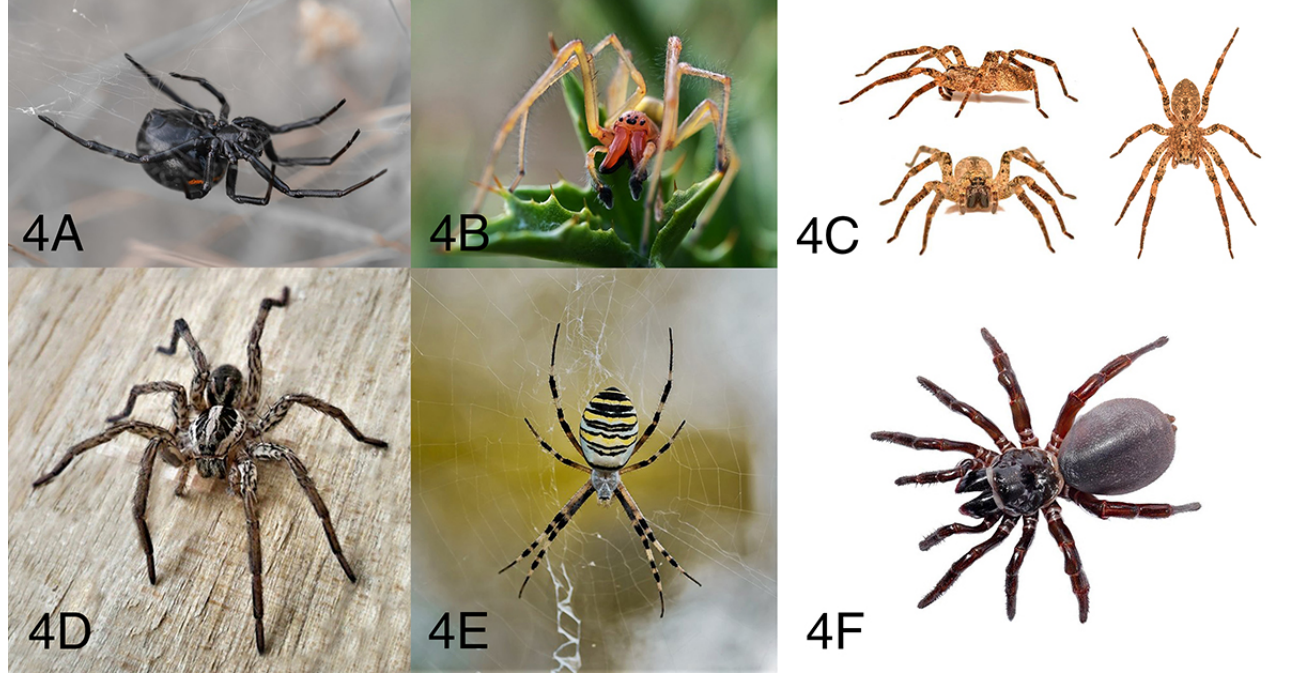
Figure 4. (A) Steatoda paykulliana (photo courtesy of Gianluigi Foggia). (B) Cheiracanthium punctorium (photo courtesy of Gianluigi Foggia). (C) Zoropsis spinimana (photo courtesy of Pierluigi Rizzo). (D) Hogna radiata (photo courtesy of Gianluigi Foggia). (E) Argiope bruennichi (photo courtesy of Gianluigi Foggia). (F) Cteniza sp. (photo courtesy of Pierluigi